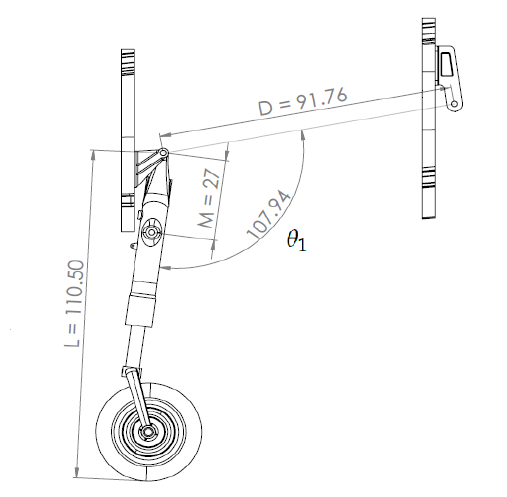
Figure 3. Nose Landing Gear dimensions for retraction mechanism (all dimensions are in